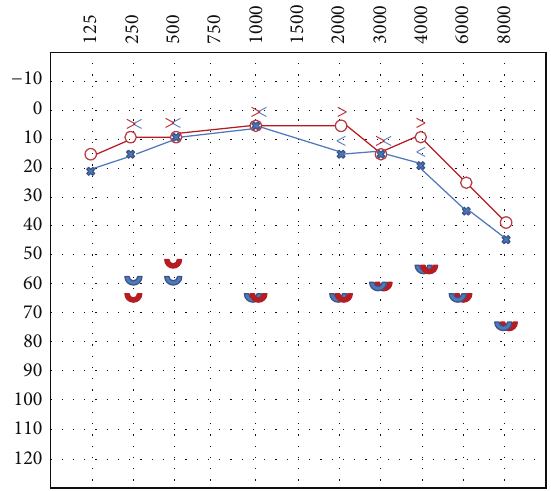
Figure 2: Audiological test with ULL showing severe hyperacusis before the